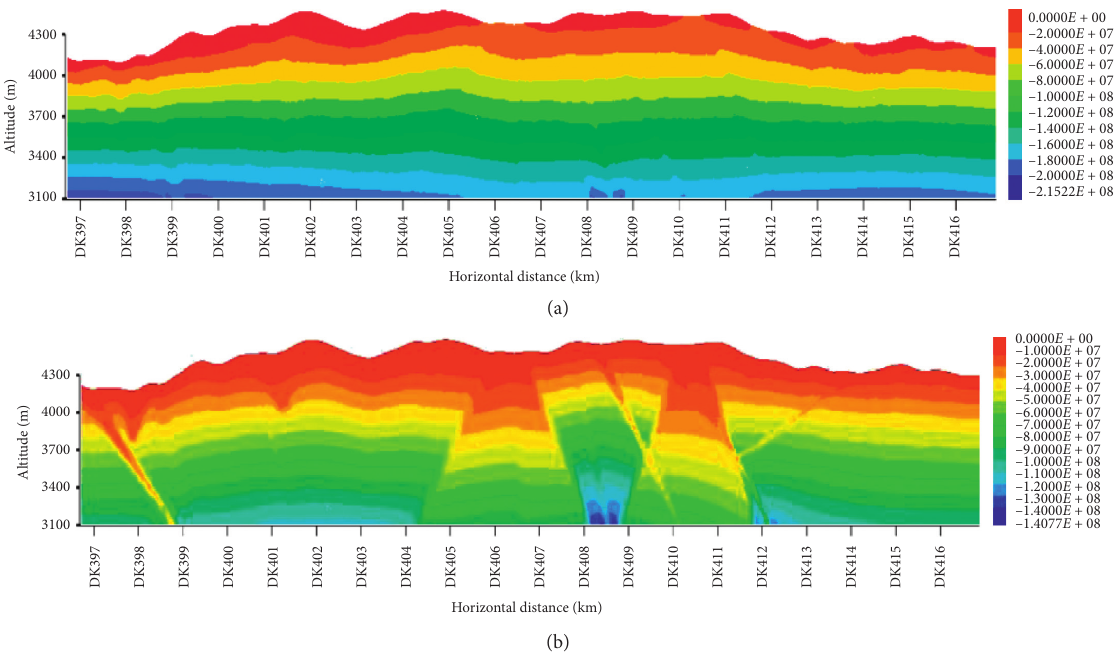
Figure 8: The principal stress nephogram of the tunnel axis section. (a) The maximum principal stress nephogram of the tunnel. (b) The minimum principal stress nephogram of the tunnel.